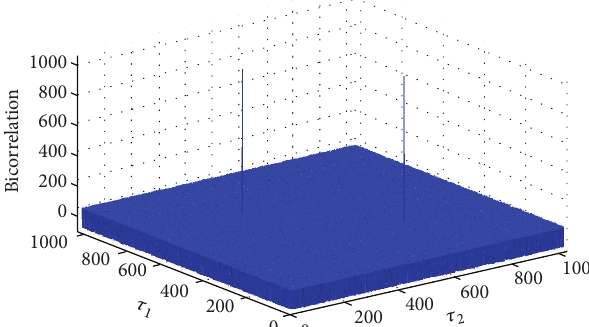
Figure 2: Plot of the bicorrelation of two Gold codes.